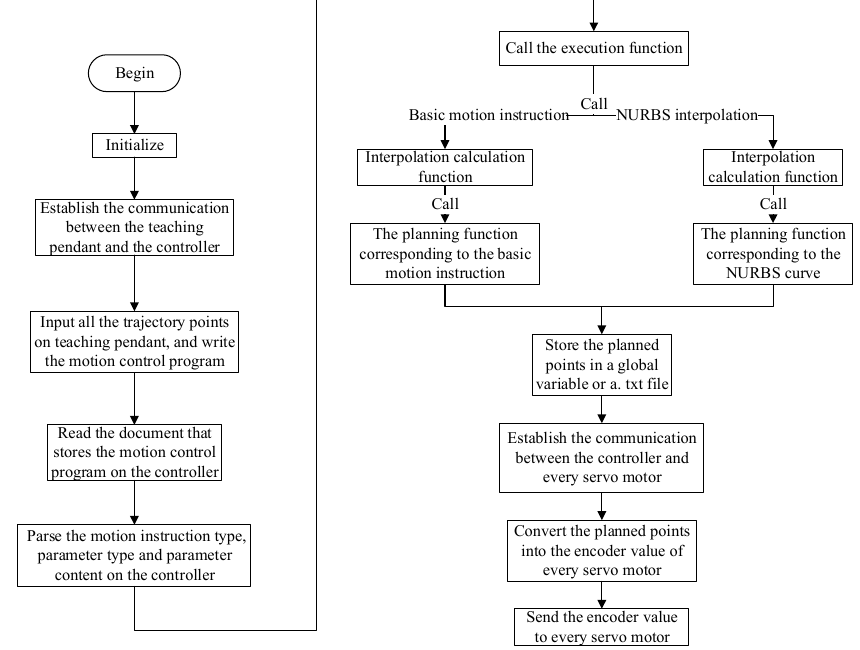
Figure 6. Online teaching flow chart.